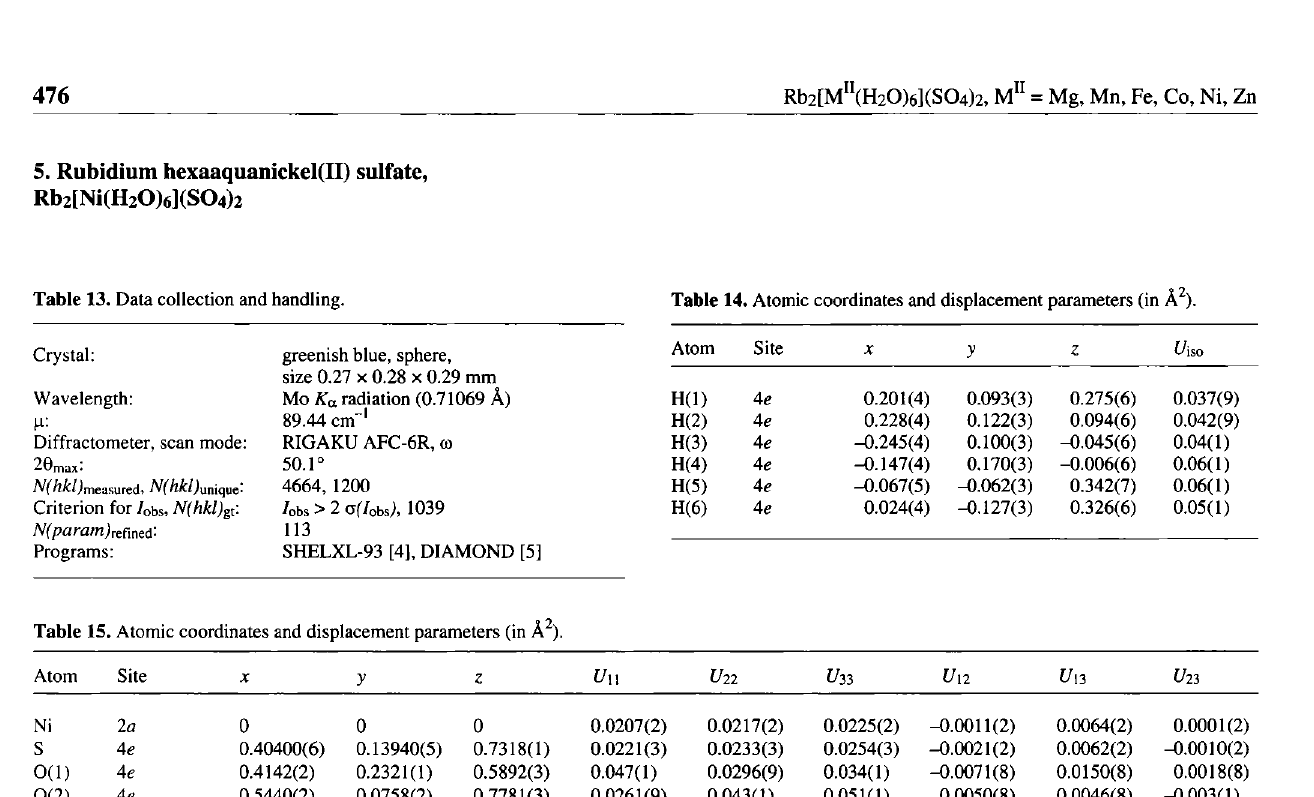
Table 15. Atomic coordinates and displacement parameters (in A 2 ).